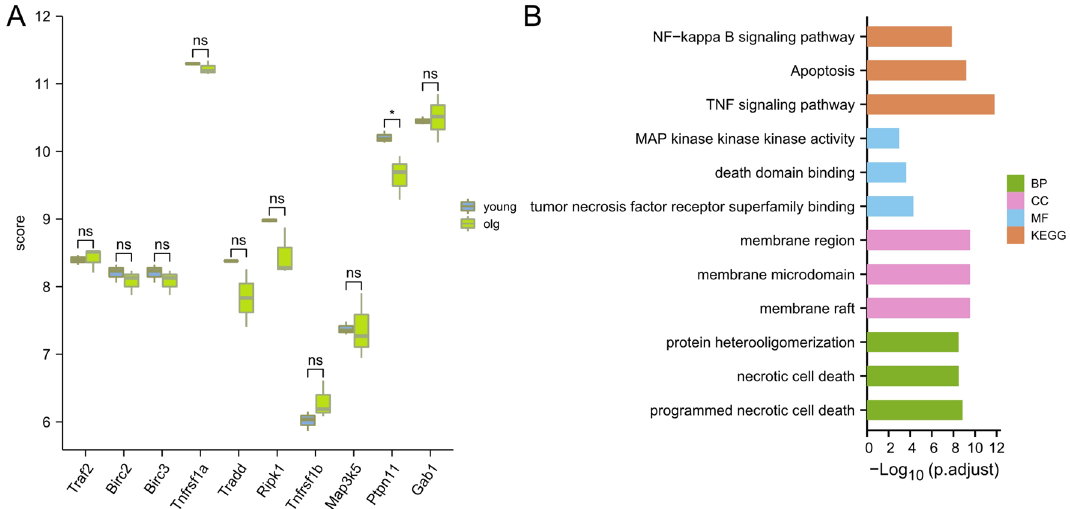
Figure 5. Analysis of hub genes: ( A ) Box diagram of the distribution of 10 hub genes in the GSE137176 dataset; ( B ) GO and KEGG analysis of 10 hub